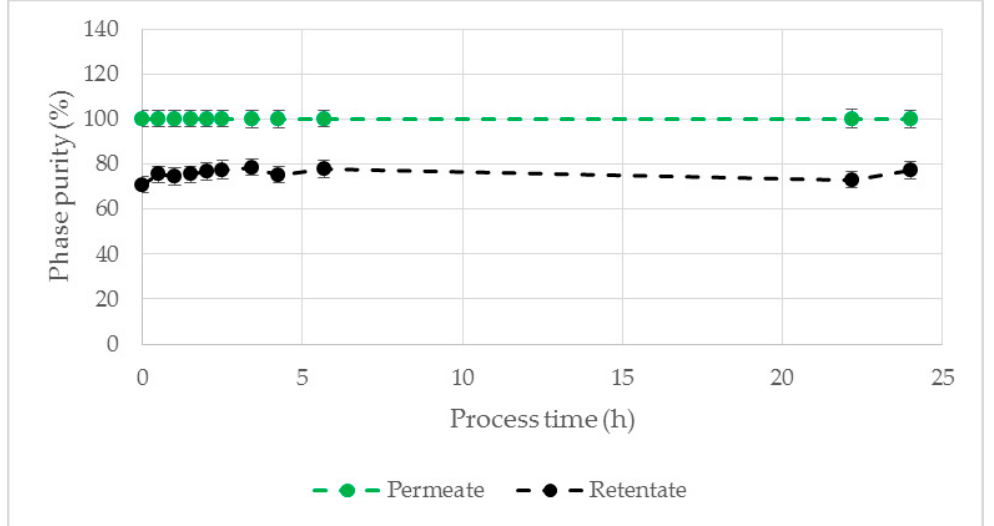
Figure 6. Phase purity of permeate and retentate (both recirculated) for a process time of 24 h. Hydrophobic PP membrane was modified with Tween20. ATPS4, TMP = 10 mbar, Δ P = 30 mbar, Q = 16.7 mL/min. PP: polypropylene.